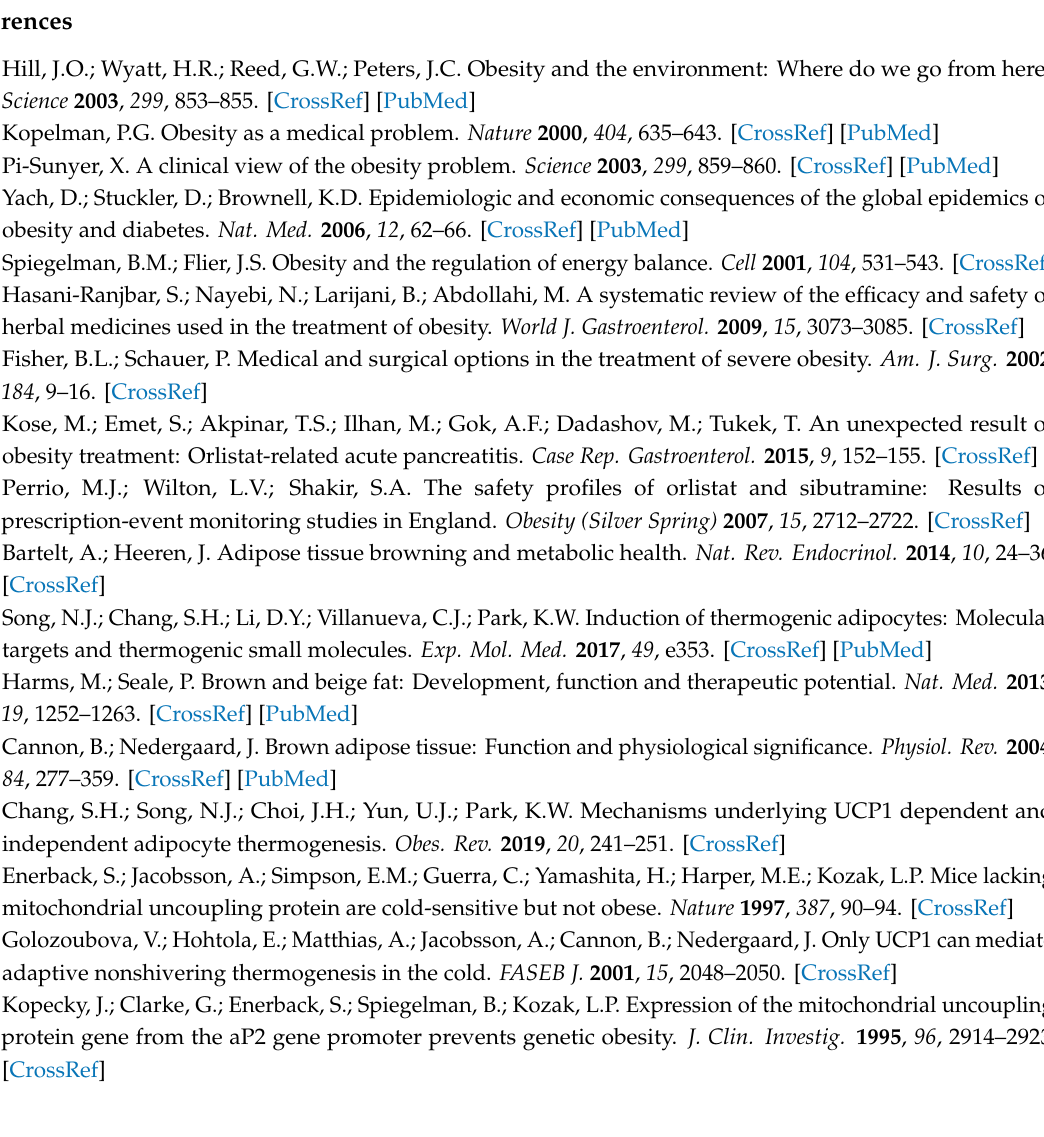
Figure S1: E ff ects of sesamol on cell viability, Figure S2: Induction of the Ucp1 expression in adipocytes by sesame lignans, Figure S3: Daily food intake in control- or sesamol-treated HFD-fed obese mice, Figure S4: Induction of the Ucp1 protein expression by sesamol in HFD-induced obese mice, Figure S5: Uncropped versions of immunoblots in the figure S4. Figure S6: Sesamol improves glucose and insulin tolerance in obese mice, Figure S7: Sesamol induces the expression of Nrf2 target genes in T37i brown adipocytes, Figure S8: tBHQ induces the expression of thermogenic genes in primary